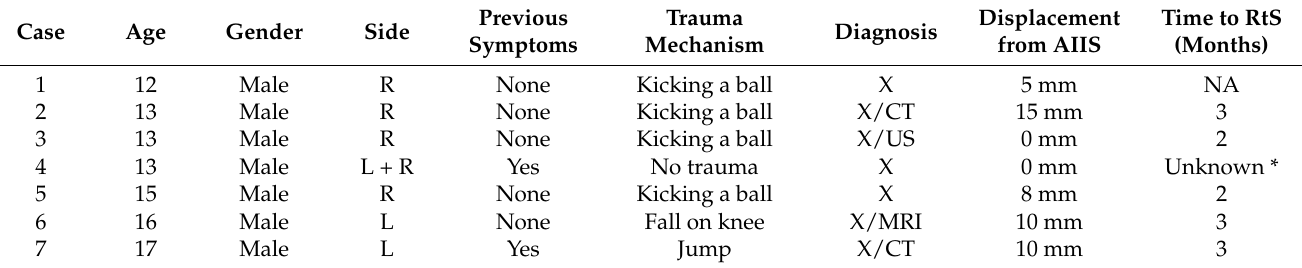
Table 1. Patient characteristics at presentation.